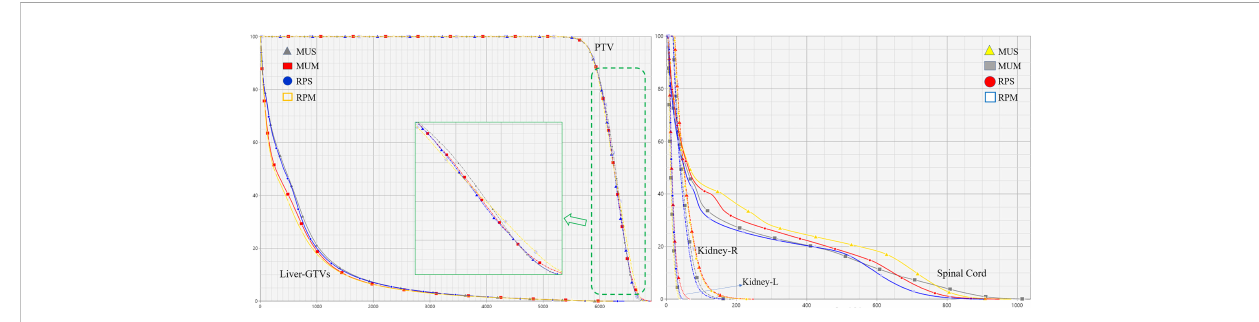
FIGURE 3 Comparison of DVHs for the PTV and